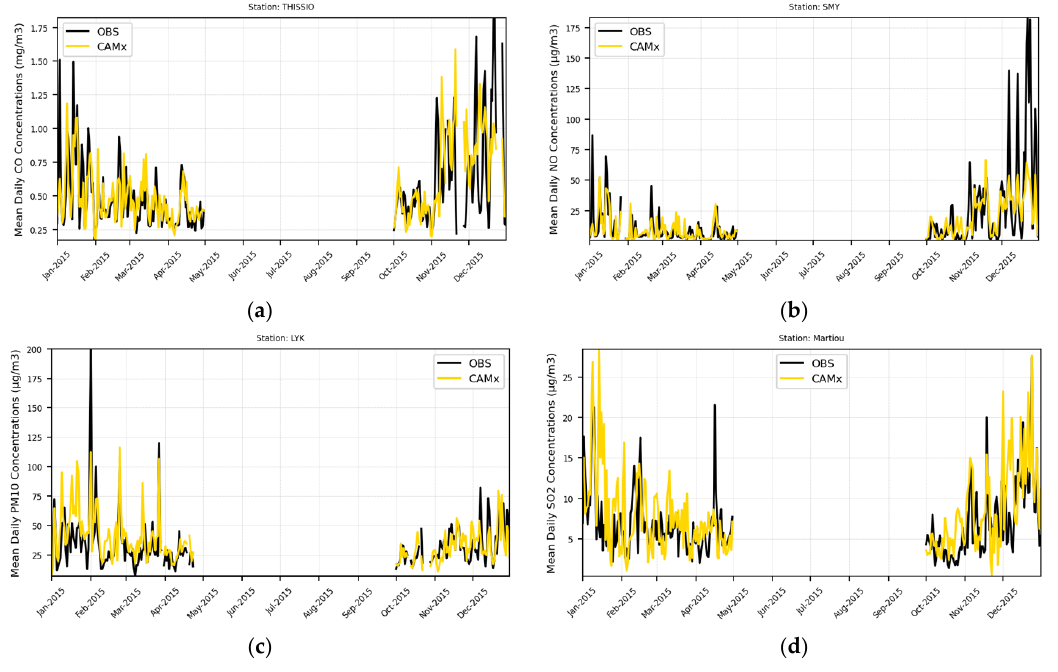
Figure 7. Mean daily ( a ) CO, ( b ) NO, ( c ) PM10 and ( d ) SO 2 concentrations of measurement and simulated data at different monitoring sites over Greece for the cold period of 2015 (January–April, October–December) for the on-line SCN. A comparison of the correlation coefficient and the Index of Agreement between the on-line SCN and static SCN was made for different pollutants and for all monitoring sites (Figure 8). The comparison showed highly improved values of R, for the on-line SCN, for all the pollutants in the different monitoring sites except for PM10 in five out of the twelve sites, for which a slight improvement is shown for the static SCN mainly due to the slight overestimation of PM10 concentrations in the on-line SCN on specific days where the simulated air temperature was low. Regarding IOA, a general improvement is identified for the on-line SCN for almost all the cases, while the IOA for NO seems to be almost the same for the two scenarios, with a slight improvement for the on-line SCN.